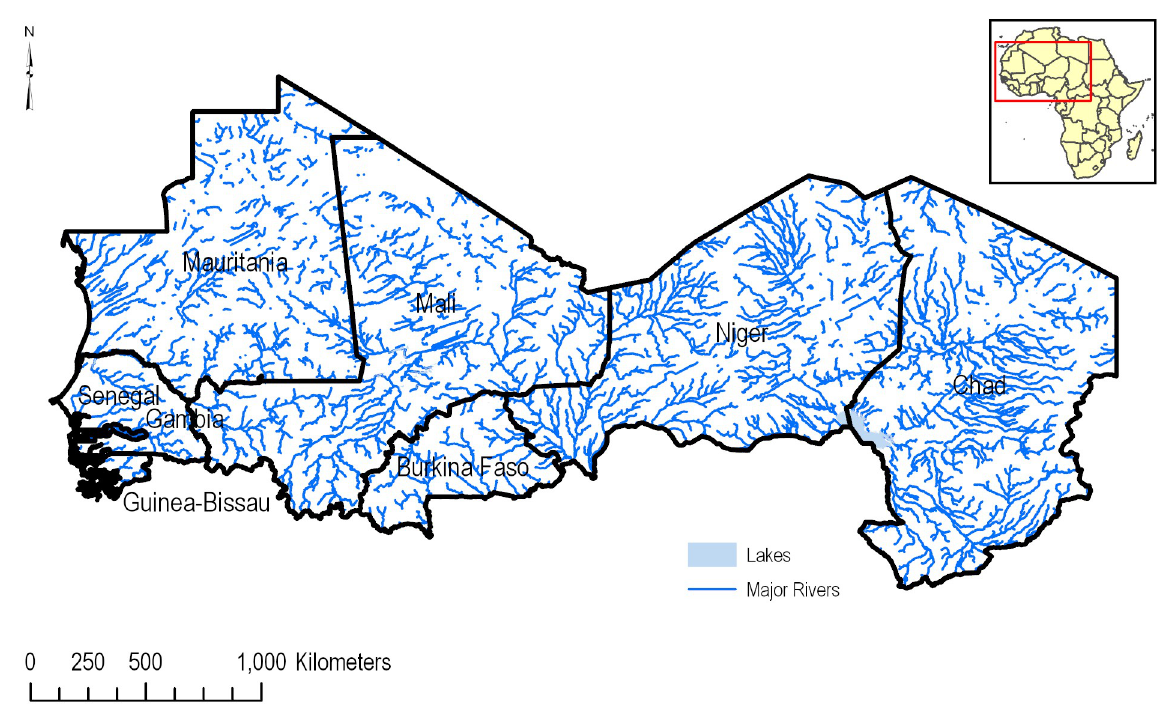
Fig 6. Location of stream flow paths in the CILSS region developed from the HydroSHEDS data. Only rivers with number of upstream cells greater than 5000 are shown.